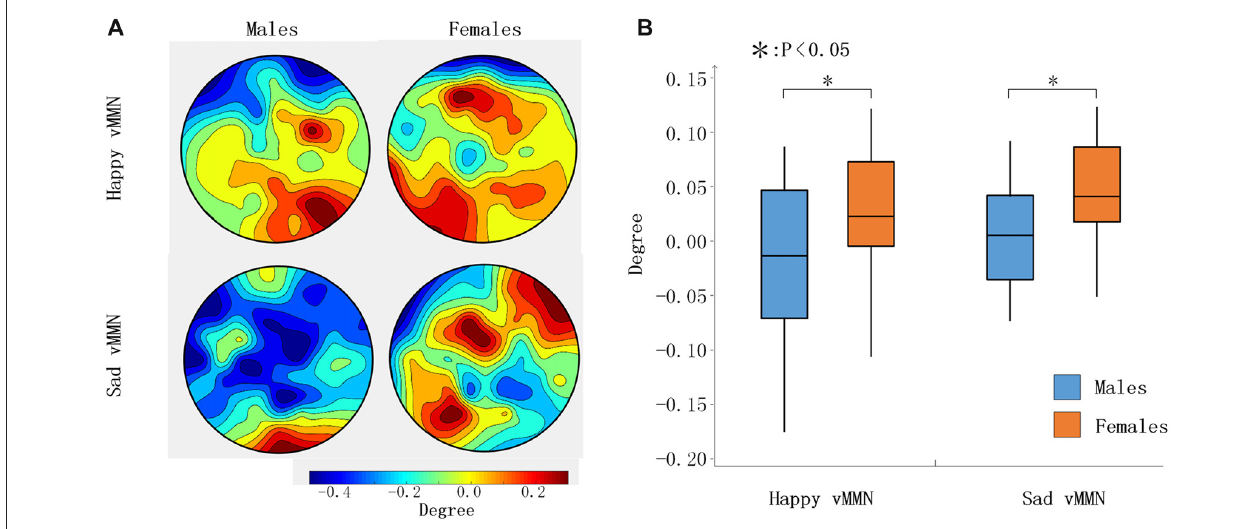
FIGURE 5 | (A) The topography shows the distribution of the degree values in regard to the happy and sad vMMN in terms of the alpha band activity at 150–250 ms. (B) Box figure of the degree values of the happy and sad vMMN for males and females in the alpha band at 150–250 ms. ∗ p < 0.05.